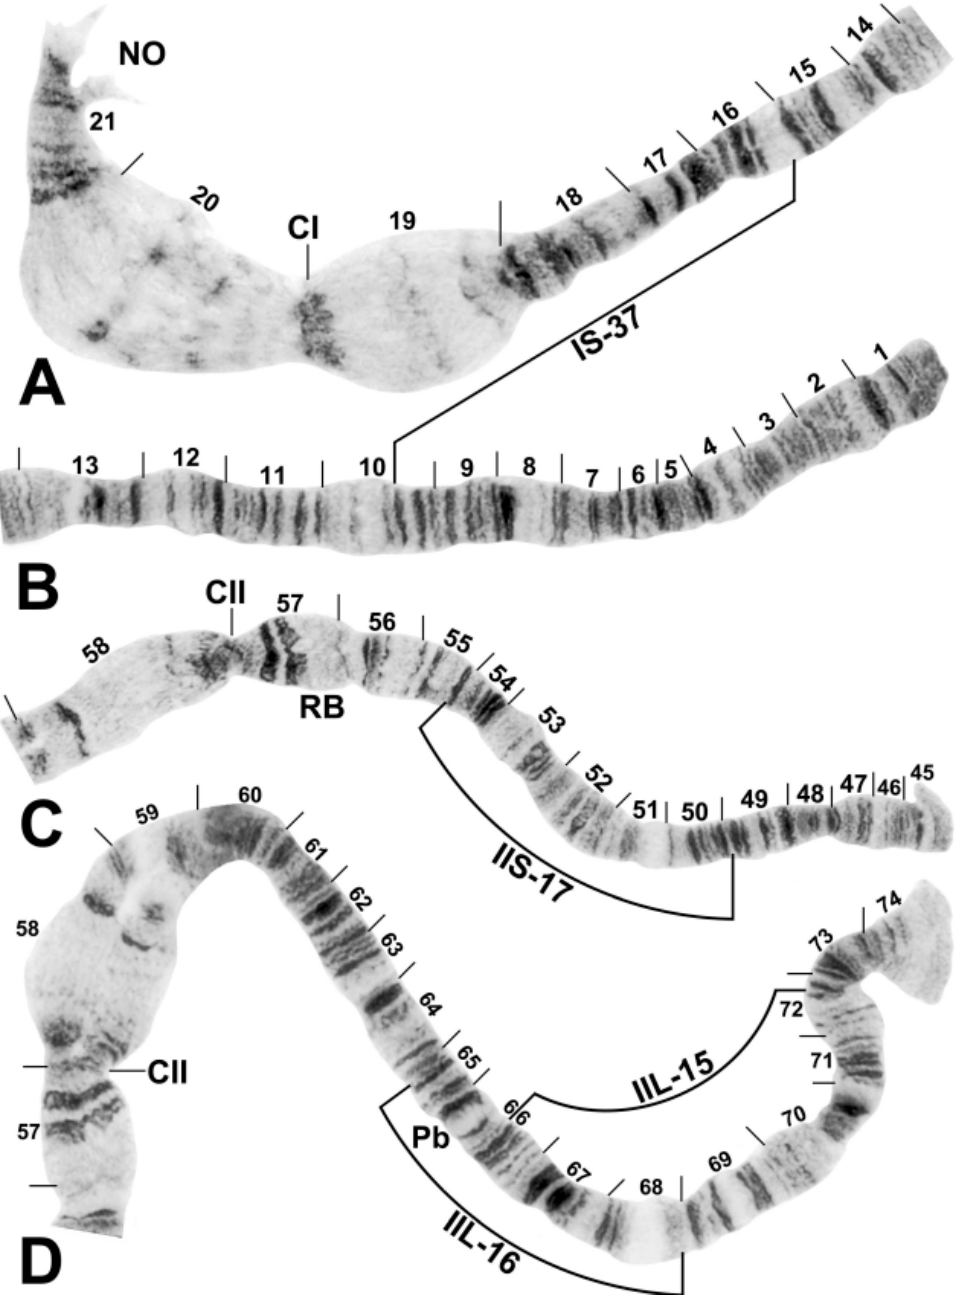
Figure 2. Chromosomes of Prosimulium supernum n. sp. from Colorado (male larvae), showing standard sequence. ( A ) . IS basal half, including standard (non-transformed) centromere region; bracket indicates breakpoints of autosomal inversion IS-37; CI, centromere of chromosome I; NO, nucleolar organizer. ( B ) . IS distal half. ( C ) . IIS; bracket indicates breakpoints of autosomal inversion IIS-17; CII, centromere of chromosome II; RB, ring of Balbiani. ( D ) . IIL; brackets indicate breakpoints of autosomal inversions IIL-15 and IIL-16; Pb, parabalbiani.